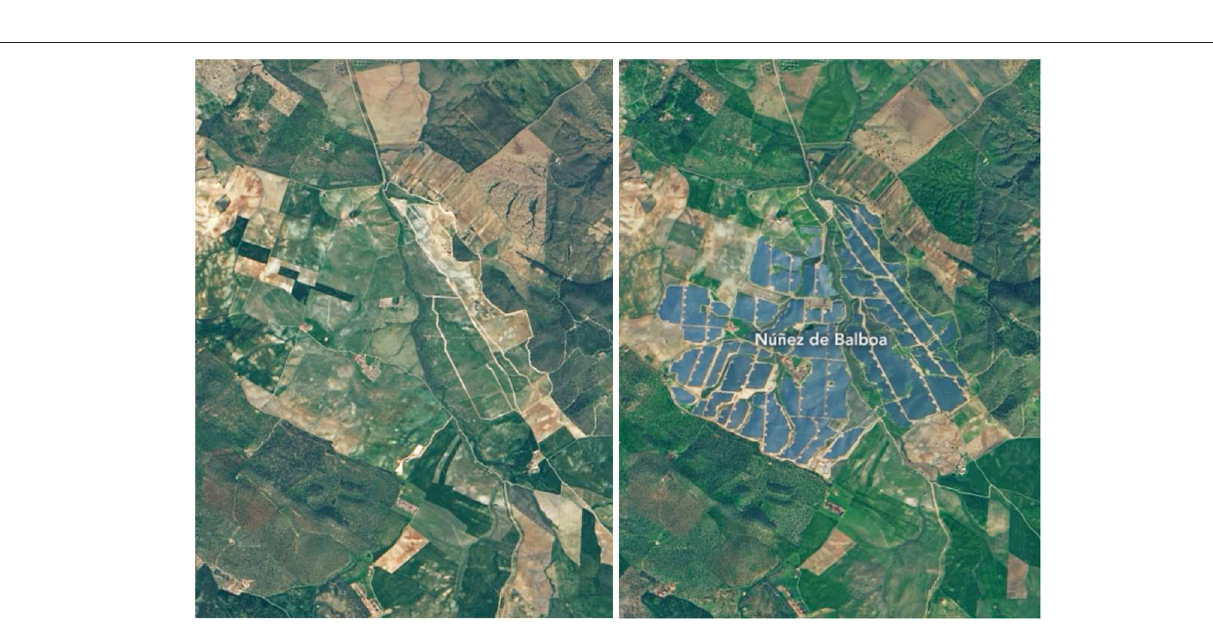
under climate agreements (see example in Figure 3 ) 3 .